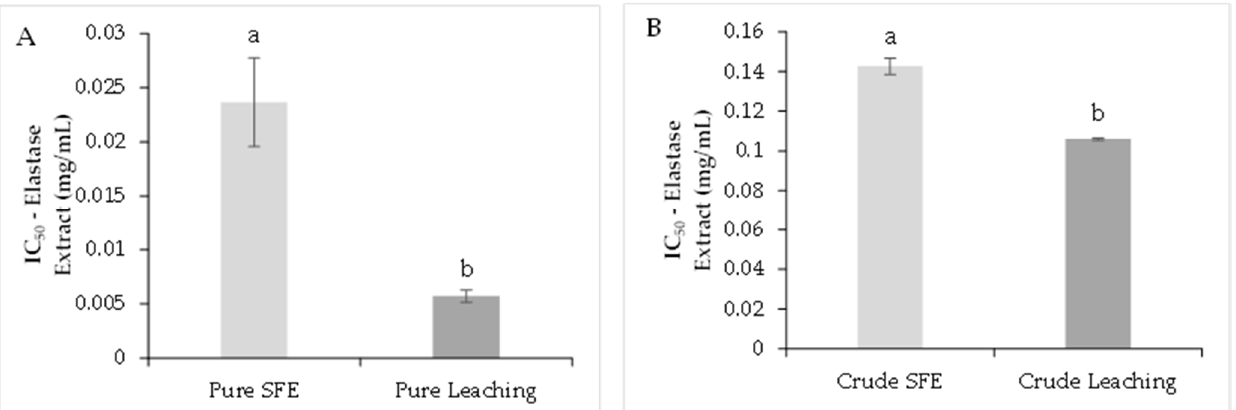
Figure 4. Elastase inhibition capacity analysis. Purified extracts ( A ), crude extracts ( B ). The results are shown as mean ± standard error. Different letters indicate significant differences among treatments ( p < 0.05) (Tukey’s HSD post hoc analysis).